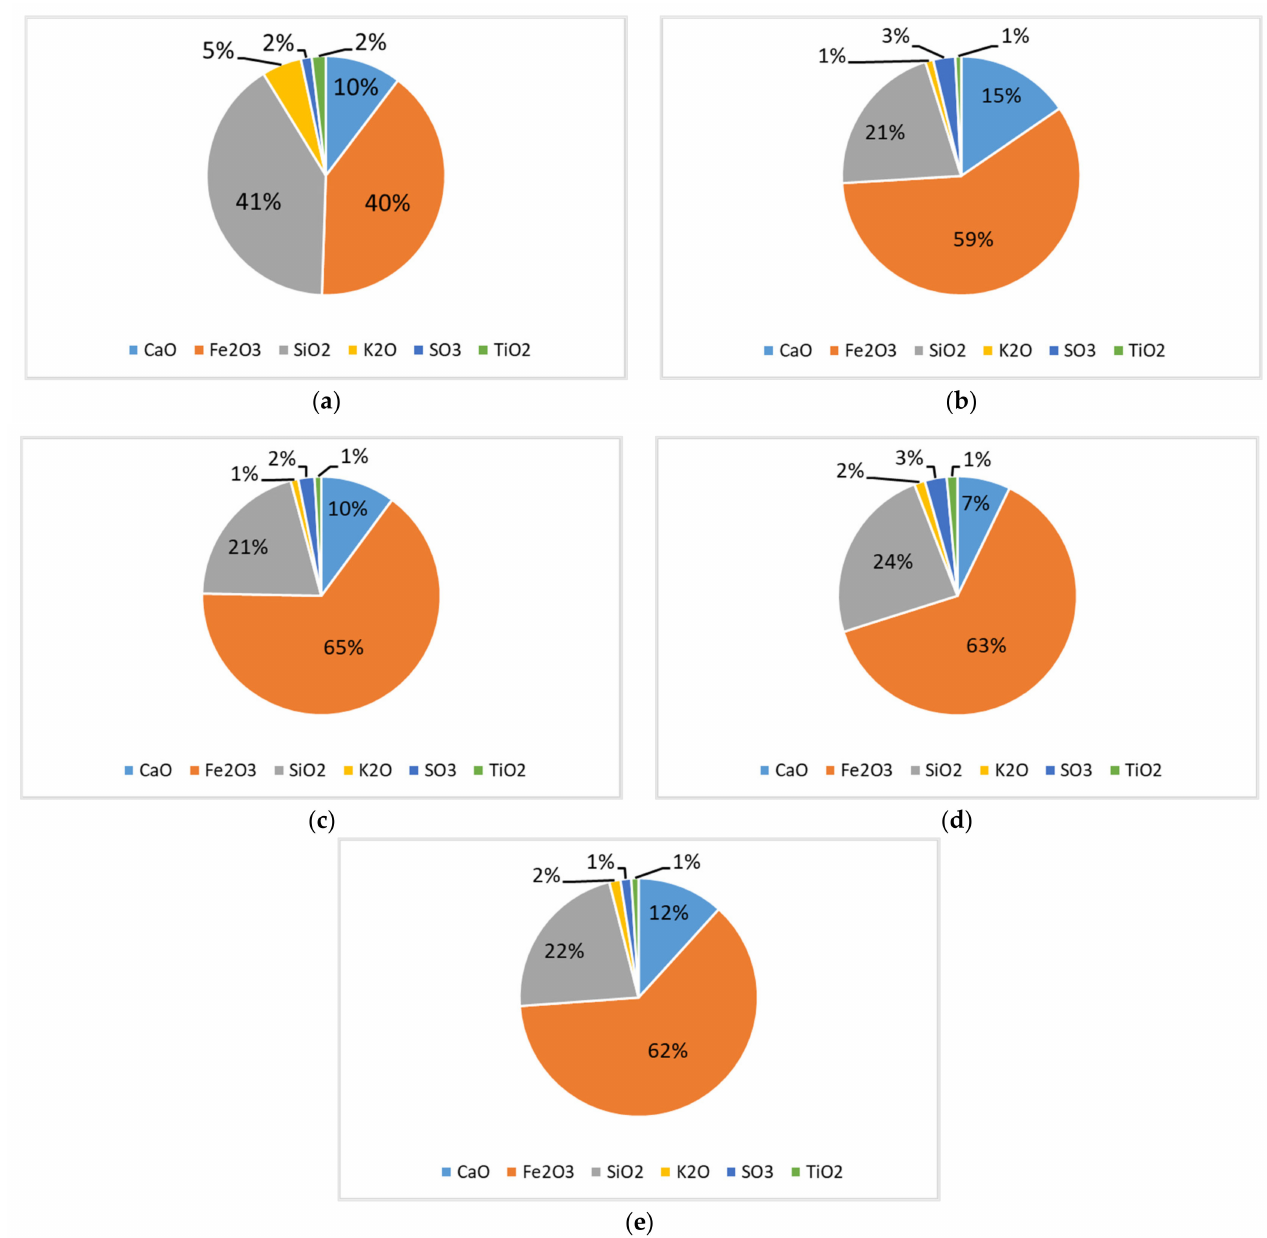
Figure 3. Chemical composition of ( a ) waste dump, ( b ) tailing, ( c ) pond 1, ( d ) pond 2, and ( e ) pond